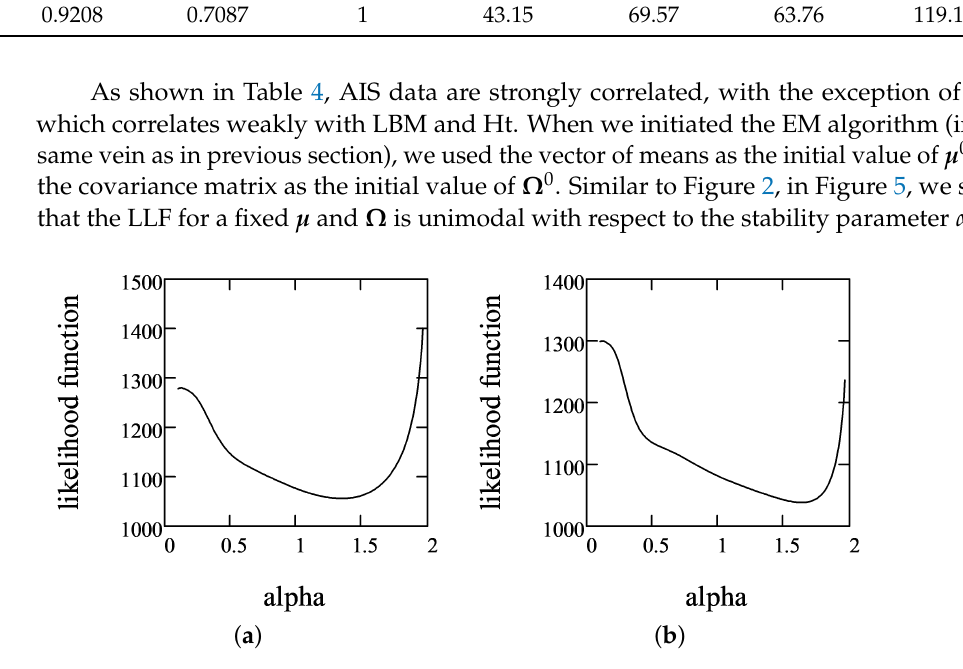
Figure 5. LLF dependence on α : ( a ) at the first iteration; and ( b ) at the last iteration for AIS data. Using the EM algorithm described in this paper, the LLF value and parameter esti- mates were registered during 100 iterations (see Figure